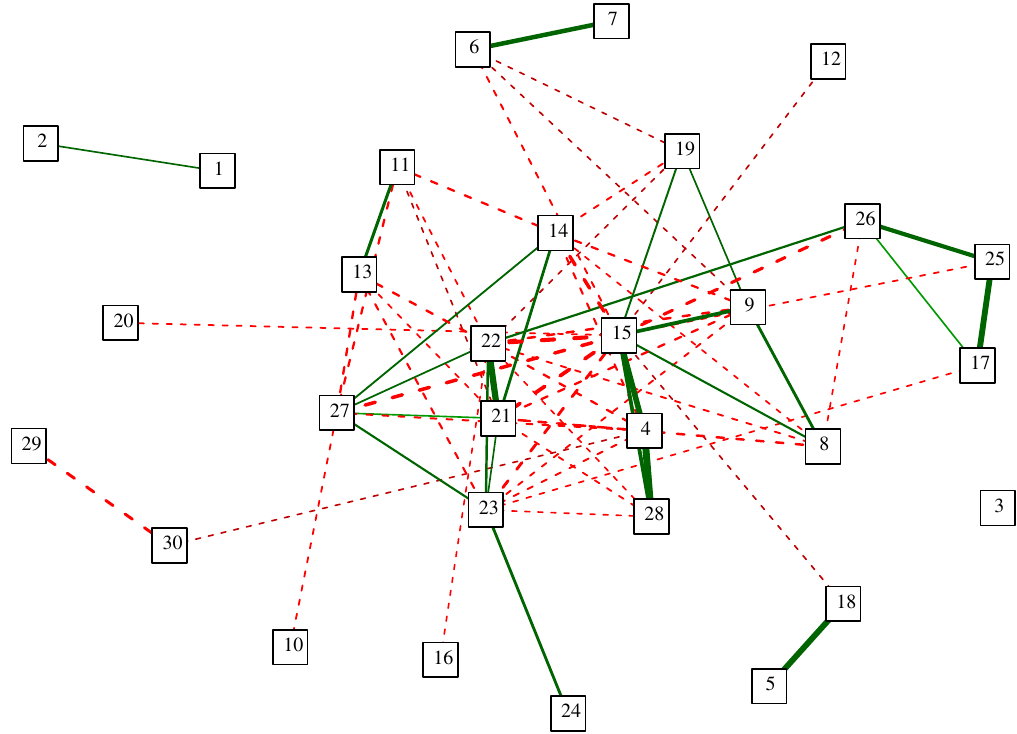
FIG. 2. Partial correlation matrix for all FCI problems correcting for total FCI score (only j r j > 0 . 1 shown). Line thickness represents the size of the correlation. Solid (green) lines represent positive correlations; dashed (red) lines negative